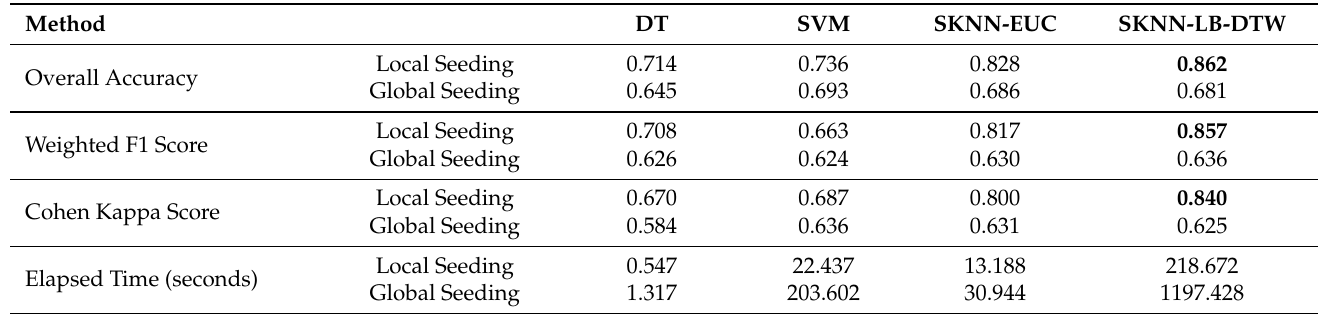
Table 3. Statistical comparison of classification performance for the third